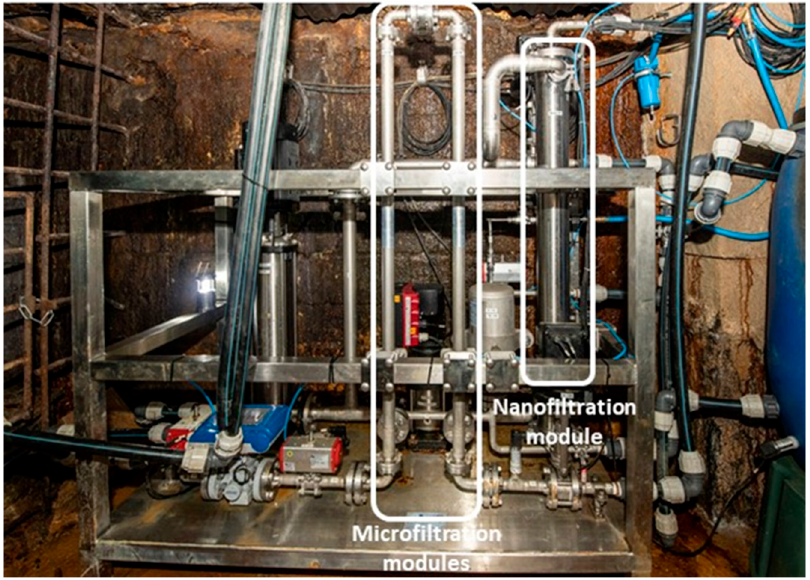
Figure 3. Membrane pilot plant at research mine Reiche Zeche.